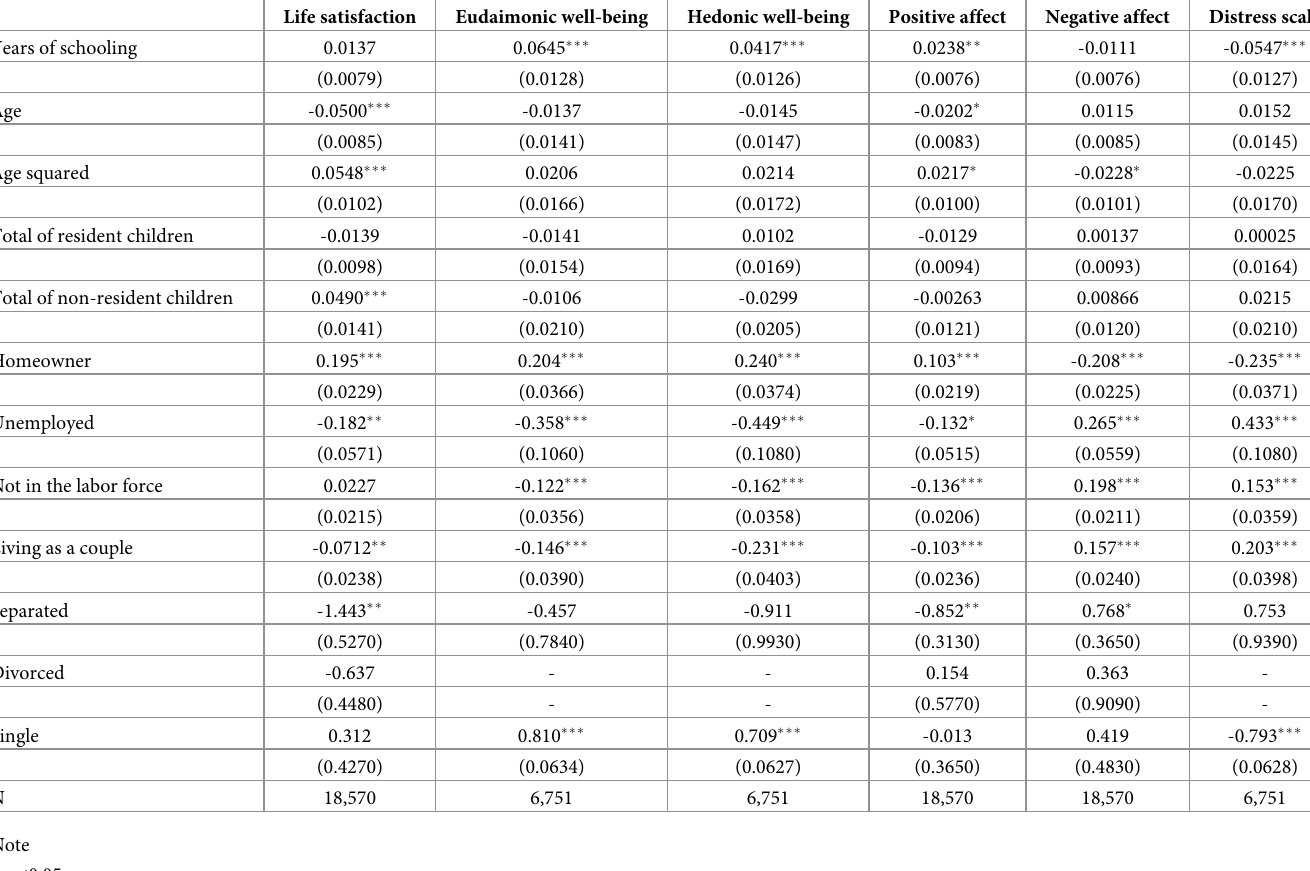
Table 4. Education and well-being with IV